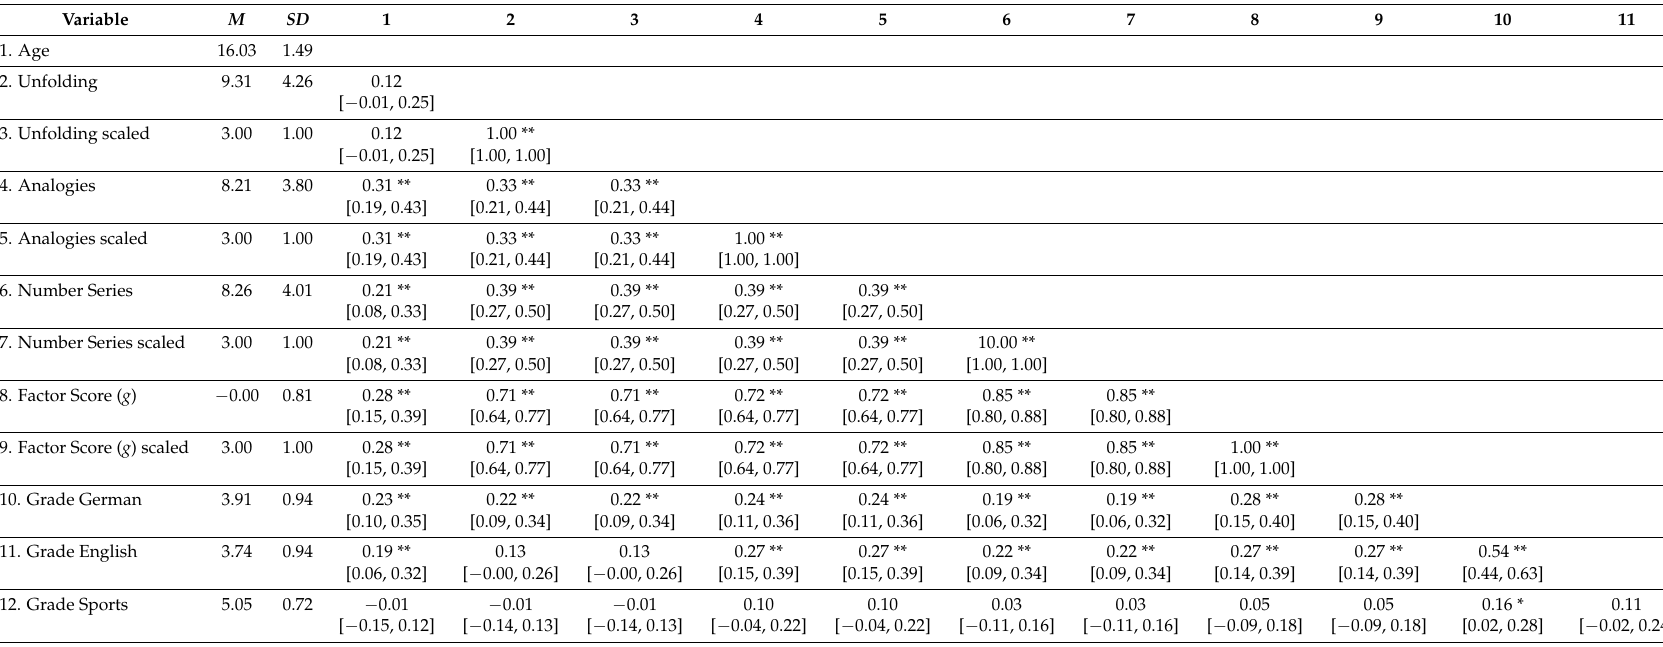
Table 1. Means, standard deviations, and correlations with confidence